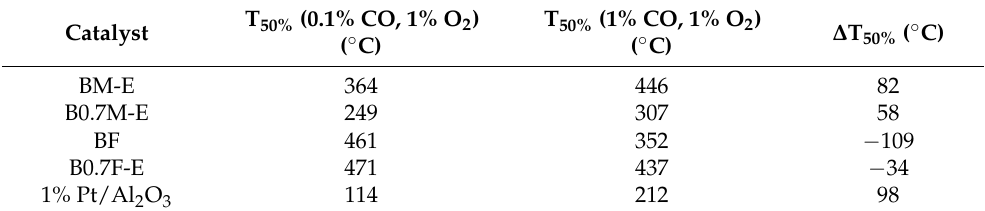
Table 4. T 50% values for the tested catalysts and T 50% change ( ∆ T 50% ) in low CO content mixture (0.1% CO, 1% O 2 ) with respect to the stoichiometric mixture (1% CO, 1% O 2 ).